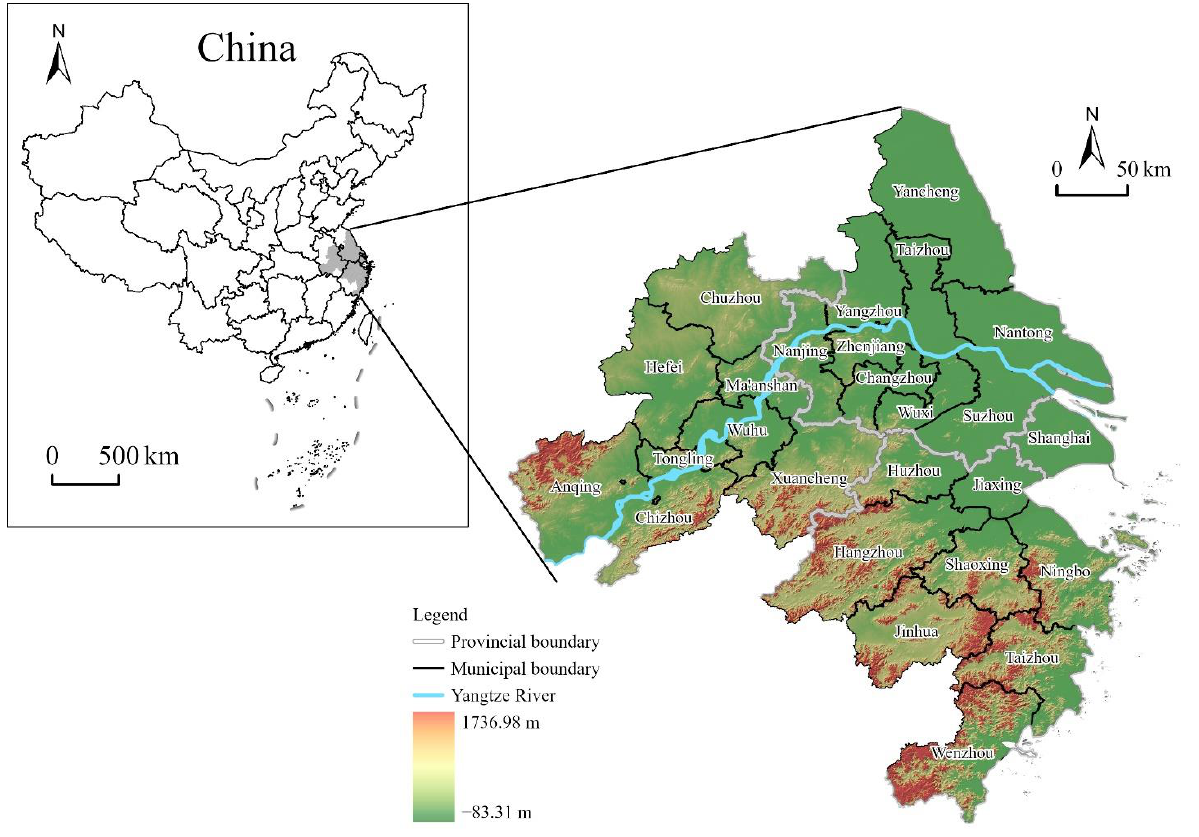
Figure 1. Location of the study area.